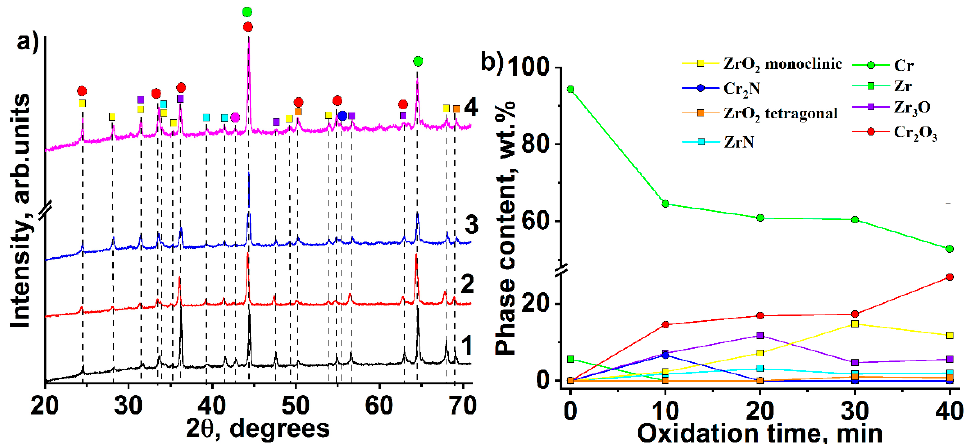
Figure 8. Diffraction patterns of the E110 alloy with the CrN/Cr-250 coating after air oxidation at 1100 °C ( a ) and phase content ( b ) depending on oxidation time: 1–10 min, 2–20 min, 3–30 min, 4–40 min.